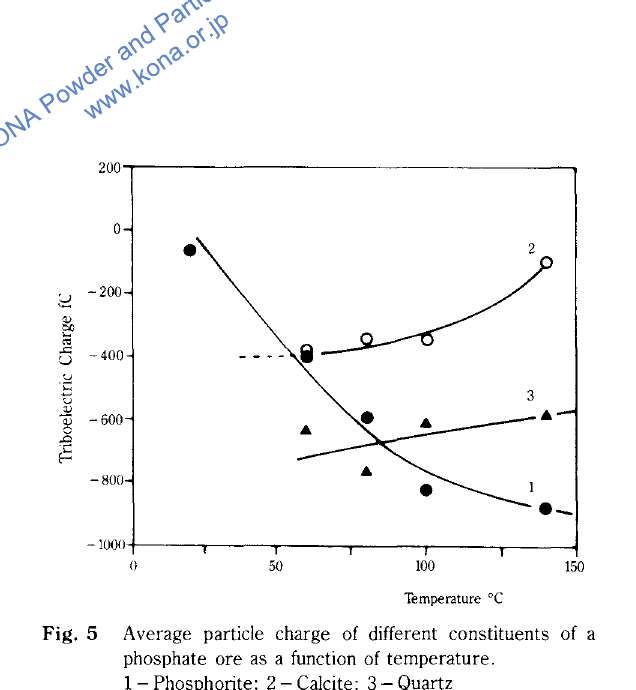
Average particle charge of different constituents of a phosphate ore as a function of temperature. 1- Phosphorite; 2- Calcite; 3- Quartz their polarity to reverse compared to that of stain less steel. On the other hand, phosphate charging is strongly sensitive to temperature, while the con tact with the gangue minerals is of no advantage or even